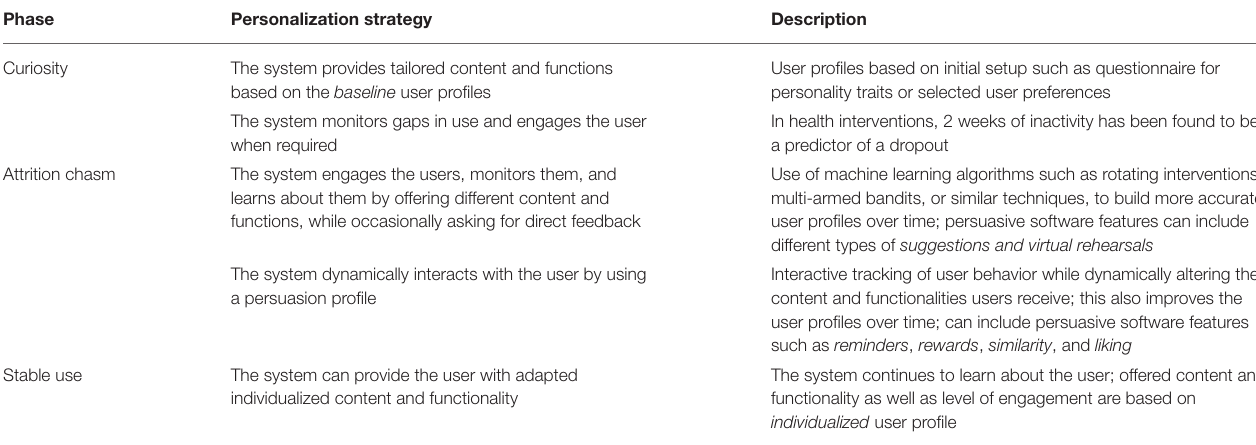
TABLE 3 | Example of true personalization strategies for health behavior change support